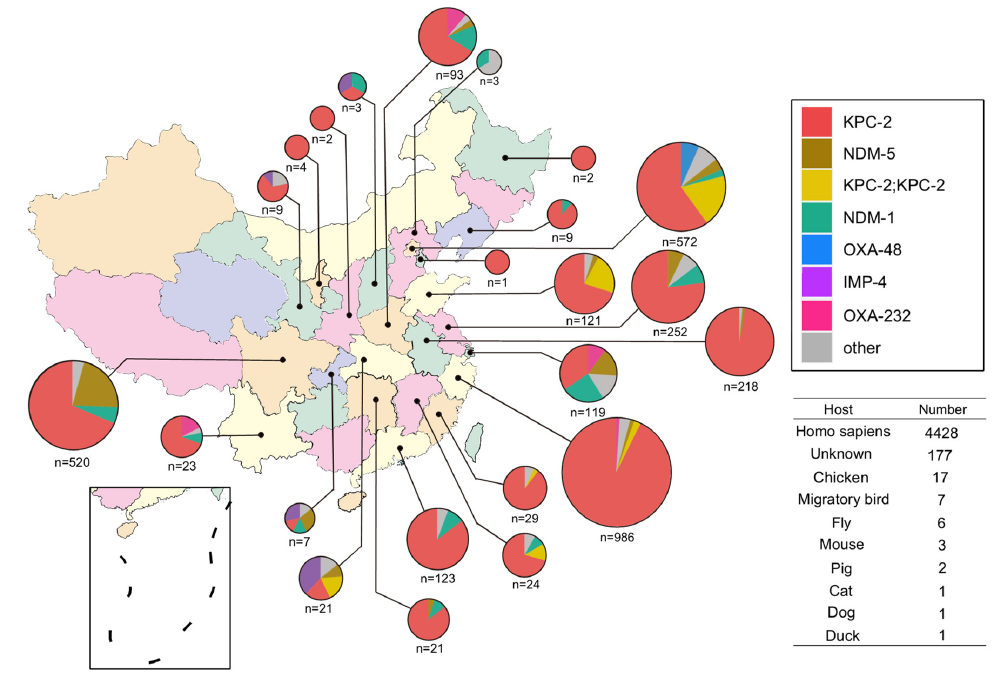
Figure 1. Carbapenemase type and geographical distribution of carbapenemase-carrying KPN. There are 152 ST types of carbapenemase-carrying KPN, of which the dominant types are ST11 (3497, 75.3%), ST15 (311, 6.7%), ST2407 (50, 1.1%), ST45 (47, 1.0%), and ST37 (42, 0.9%) (Figure 2a). Fifty-nine strains had polymorphism variations of a single housekeeping gene, five strains had gene polymorphism of two housekeeping genes, and one strain had gene polymorphism of three housekeeping genes. 2.1. Antimicrobial Resistance Among these carbapenemase-carrying KPN, KPC-2 was the dominant enzyme type (3841/4643, 82.7%), including 3216 strains of KPC-2, 621 strains of KPC-2-KPC-2, and 4 strains of KPC-2-KPC-2-KPC-2. The NDM family was the second largest enzyme type, dominated by NDM-5 and NDM-1. NDM-5 (264/4643, 5.7%) included 15 strains of NDM- 5-NDM-5. NDM-1 (183/4643, 3.9%) included 16 strains of NDM-1-NDM-1. The third largest enzyme type was the OXA family, dominated by OXA-232 (110/4643, 2.4%) and OXA-48 (43/4643, 0.9%). OXA-232 included 4 strains of OXA-232-OXA-232. The fourth largest enzyme type was IPM-4 (44/4643, 0.9%), which included 4 strains of IMP-4-IMP-4 (Figure 2b). Furthermore, there were a few combinations of serine enzymes and metalloenzymes, such as KPC-2-NDM-1 (25 strains), KPC-2-NDM-5 (22 strains), and KPC- 2-OXA48 (8 strains), and metalloenzyme combinations, such as IMP-4-NDM-1 (7 strains). The main enzyme types of ST11 were KPC-2 (2866/3497, 82.0%) and KPC-2-KPC-2 (515/3497, 14.7%) (Figure 2c). ST15 was dominated by KPC-2 (123/311, 39.5%), OXA-232 (99/311, 31.8%), and KPC-2-KPC-2 (71/311, 22.8%) (Figure 2d).